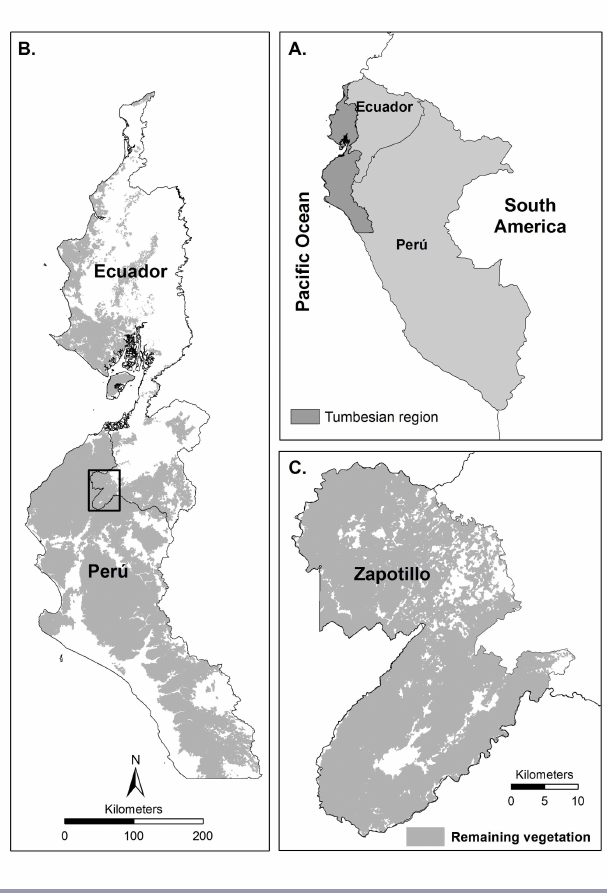
Fig. 1. Maps of the study location. (A) Map of the Tumbesian region located in Pacific coastal Ecuador and northern Peru. (B) Location of Zapotillo County, southwestern Ecuador. (C) Map of the remnant forest vegetation of Zapotillo